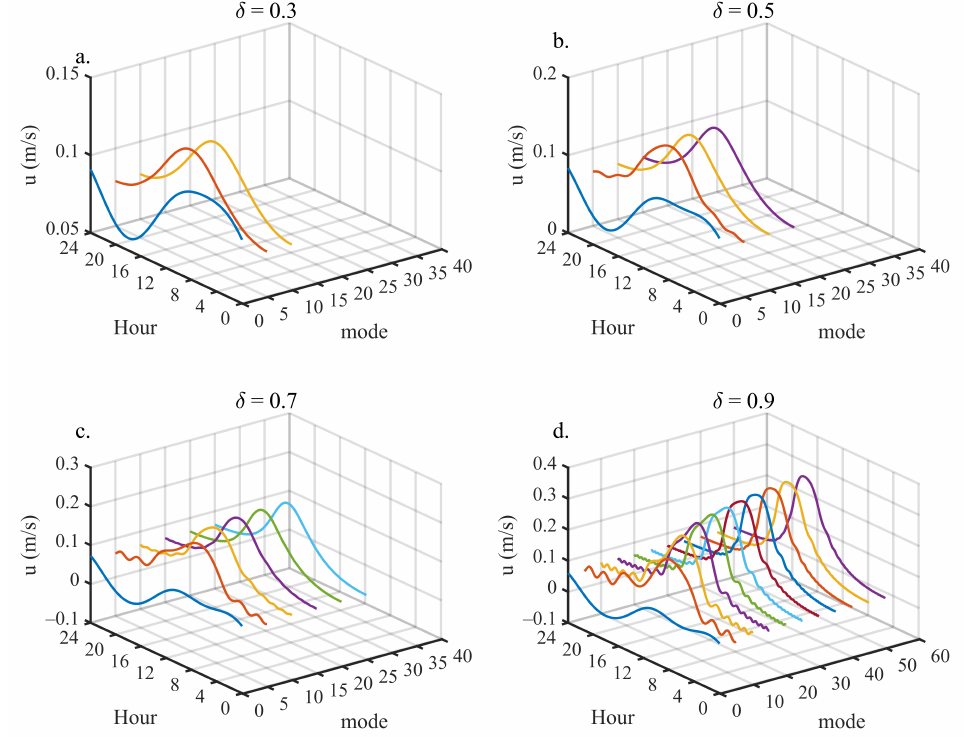
Figure 2. Mode dependence of surface zonal velocity u 0 for ( a ) δ = 0.3, ( b ) δ = 0.5, ( c ) δ = 0.7, ( d ) δ = 0.9, under the same steady wind stress and at a latitude of 45°